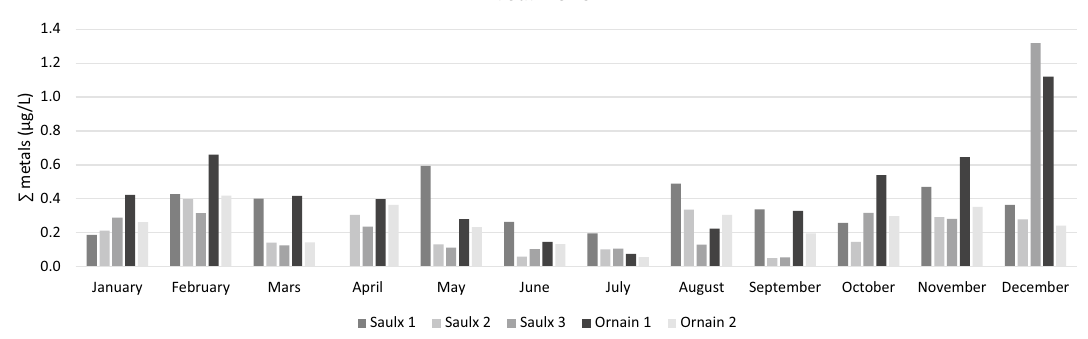
Fig. 7 Sum of metals TWA (Cu, Cr, Ni, Pb, Zn) from January to December 2015 at the five monitoring stations on the Saulx and Ornain